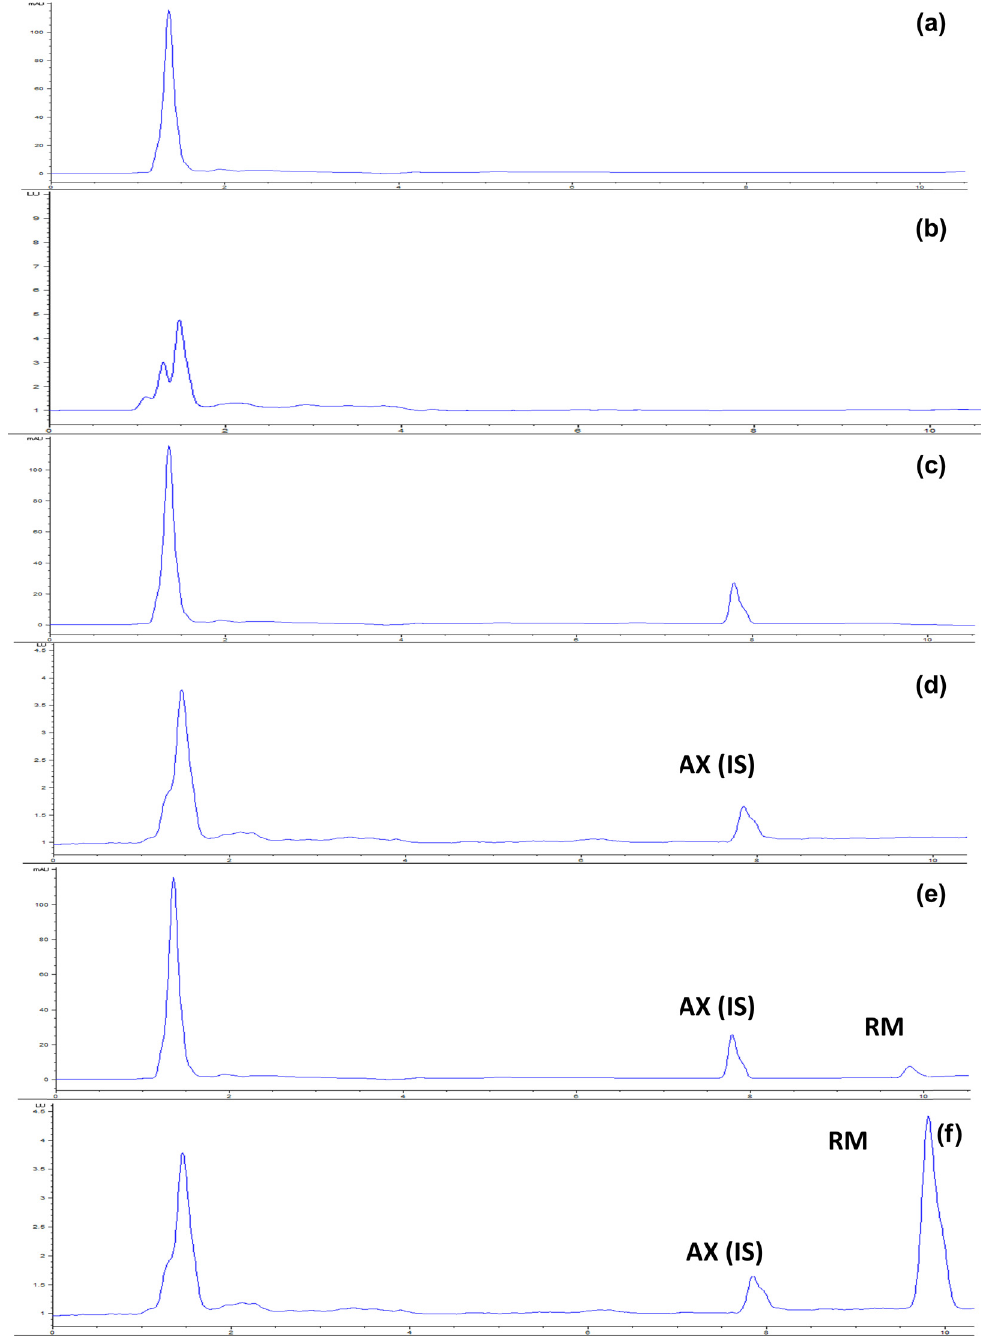
Figure A1: Representative HPLC chromatograms of ( a ) blank plasma ( DAD, 240 nm ) , ( b ) blank plasma ( FD, λ ex / em 245/390 nm ) , ( c ) treated blank plasma with IS ( DAD, 240 nm ) , ( d ) treated blank plasma with IS ( FD, λ ex / em 245/390 nm ) , ( e ) extracted plasma spiked at the LLOQ levels with IS ( DAD, 240 nm ) , and ( f ) extracted plasma spiked at the LLOQ levels with IS ( FD, λ ex / em 245/390 nm )